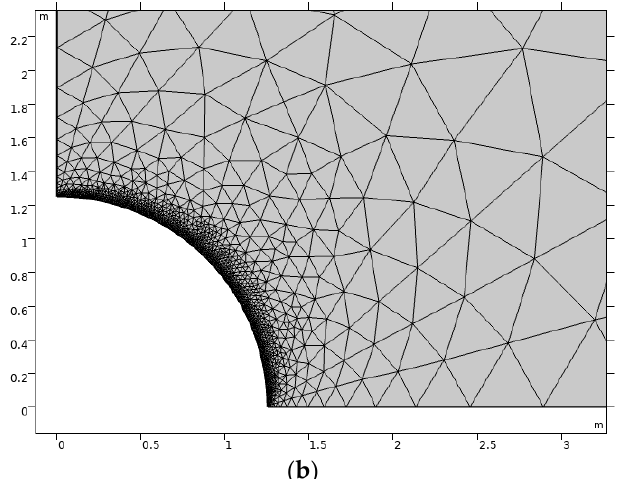
Figure 2. The computational mesh of the COMSOL Multiphysics model: ( a ) whole domain, ( b ) finer discretization near tunnel boundary.